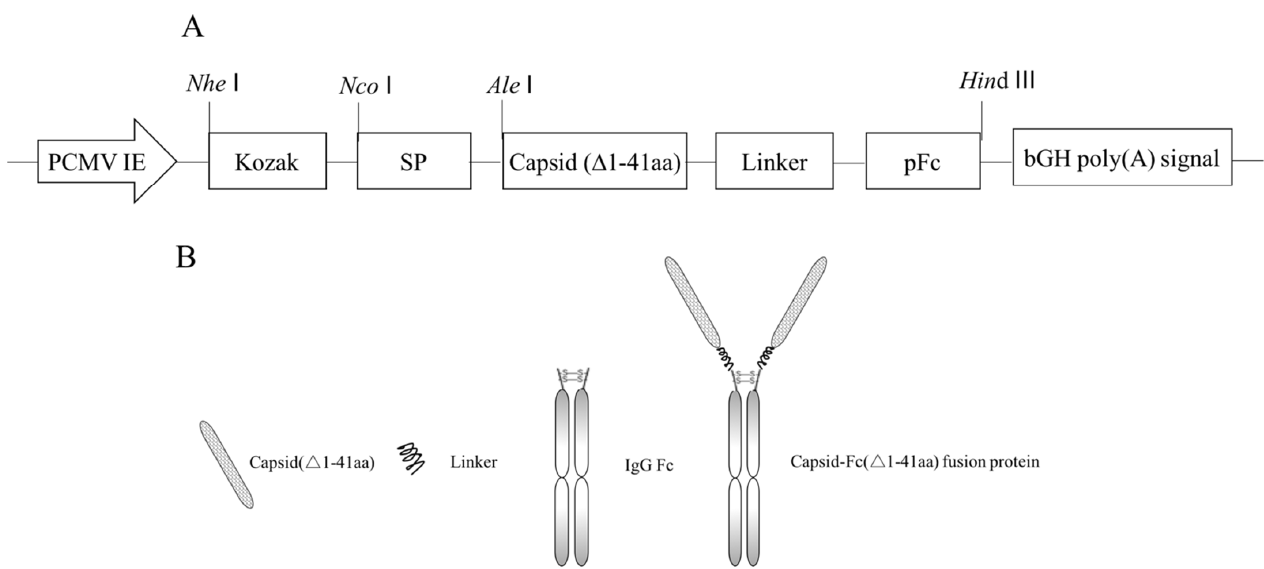
Figure 1. Schematic diagram of the expression vectors and fusion protein. ( A ) Gene expression cassette of the PCFP fusion protein. PCMV IE, the human cytomegalovirus immediately early promoter with the human cytomegalovirus immediate early enhancer region; Kozak, Kozak consensus; SP, Human IgG2 heavy chain signal peptide; Capsid ( ∆ 1-41aa), truncated (41 N-terminal amino acids) PCV2 capsid gene; Linker, linker peptides (GSGGGSGGGGSGGGS); pFc, Fc domain gene of the porcine IgG heavy chain. ( B ) Schematic representation of PCFP fusion protein. The PCFP fusion protein comprised a truncated PCV2 capsid and a porcine IgG Fc fragment which was fused to the capsid at the C-terminus via the linker